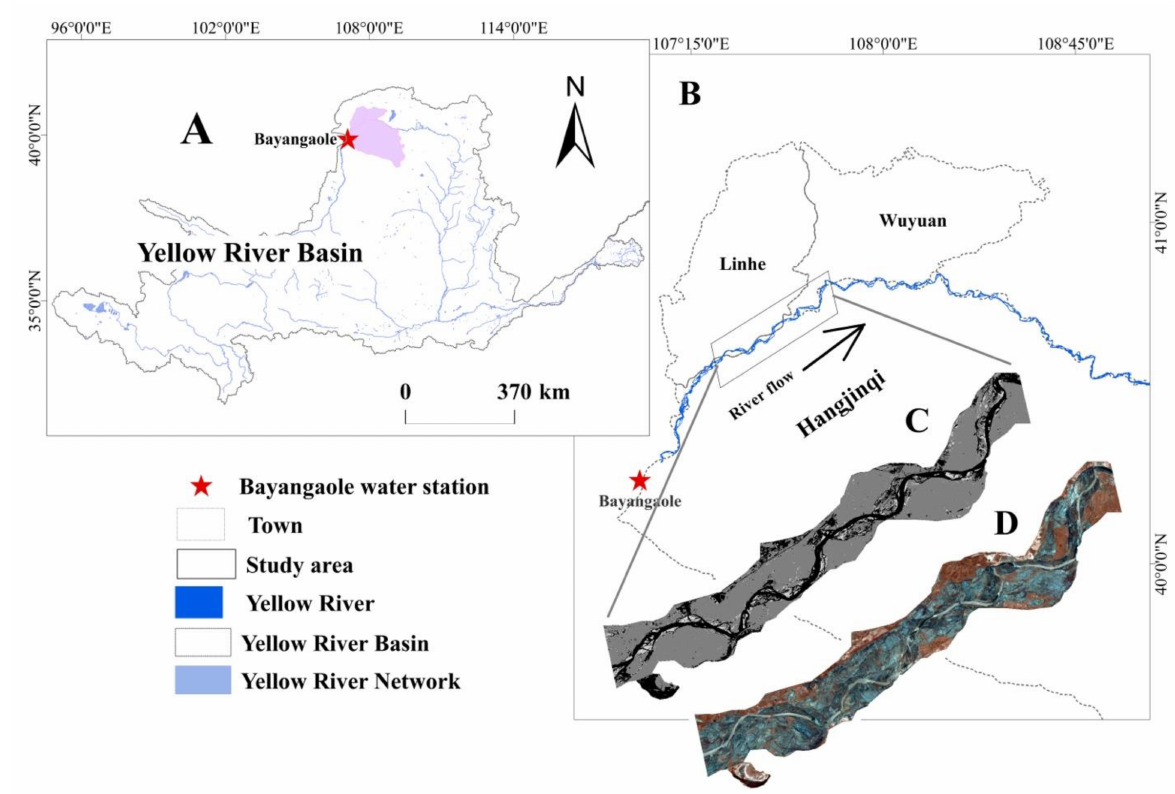
Figure 1. Location of the study area and conceptual model of hydrogeomorphological interaction patterns ( A ) The Yellow River Basin and location of the Linhe Reach (indicated by the solid line box); ( B ) The Linhe Reach and location of the study area (indicated by the dashed-line box); ( C ) NDVI image of the study area on the 15 August 2015; Pixel-based points P1–P4 are located along a cross-section at different distances from riverbed; ( D ) False colour composite Landsat 8 of the study area collect from 12 January